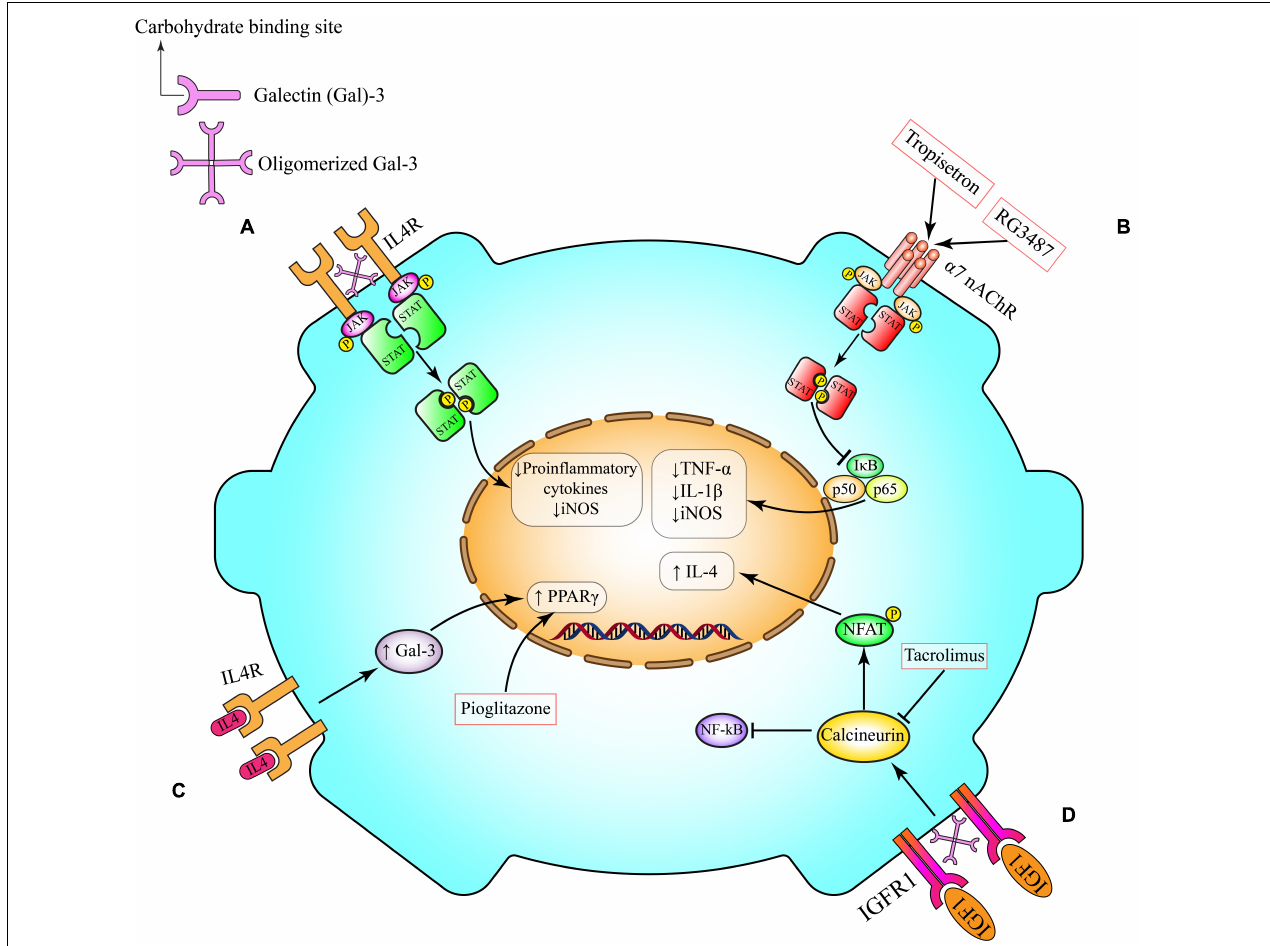
FIGURE 2 | Anti-inflammatory pathways in microglia. (A) Gal-3 induces alternative microglia activation through interaction with IL-4 receptor (IL4R). Following Gal-3 lattice formation the carbohydrate-binding site of Gal-3 molecules interacts with glycosylated IL4R and prevents their endocytosis and also over activation of IL4R and its anti-inflammatory signaling. (B) Activation of α 7 nAChR on microglia triggers anti-inflammatory cascades, including Janus kinase (JAK)/signal transducer and activator of transcription (STAT) and PI3K/Akt, which potentiate the activity of transcriptional factor Nrf2 and its downstream pathways (HO-1 and CAT), and inhibits the canonical proinflammatory protein NF κ B, which governs the production of proinflammatory cytokines (e.g., TNF- α ) and enzymes (e.g., iNOS and COX-2) involved in neuroinflammation. This pathway can be induced by tropisetron and RG3487. (C) IL-4 can interact with its tyrosine kinase IL4R on microglia cell surface. This interaction might activate one of the canonical transcriptional factors that are involved in microglia polarization such as PPAR- γ . Pioglitazone activates PPAR- γ . (D) By crosslinking insulin-like growth factor 1 receptor (IGFR-1), secreted Gal-3 will prevent early endocytosis and over-activate the Janus kinase (JAK)/signal transducer and activator of transcription STAT pathway and the transcription of genes needed for production of anti-inflammatory cytokines such as IL-4. IL-4, interleukin 4; iNOS, inducible nitric oxide synthase; TNF- α , tumor necrosis factor- α ; JAK, Janus kinase; STAT, signal transducer and activator of transcription; NFAT, nuclear factor of activated T-cells; NF- κ B, nuclear factor kappa B; α 7 nAChR, α 7 nicotinic acetylcholine receptors; Gal-3, galectin-3; IGFR, insulin-like growth factor 1 (IGF-1) receptor; PPAR- γ , peroxisome proliferator- activated